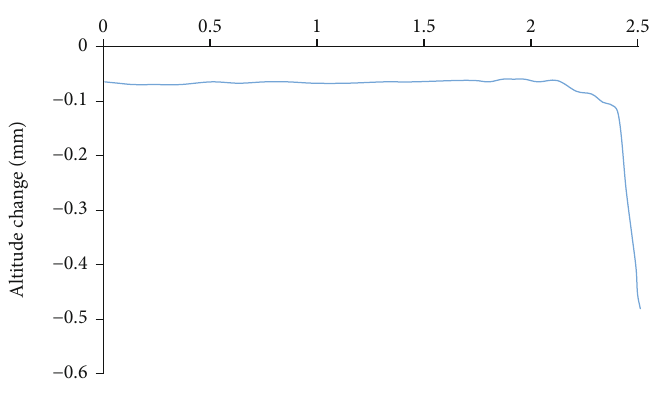
Figure 23: Height variation of proppant column.